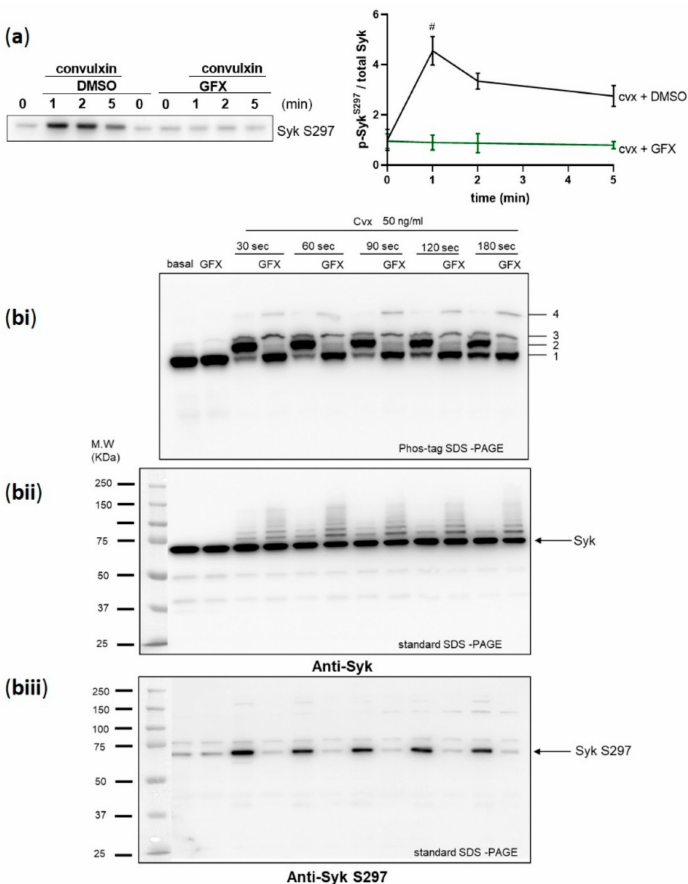
Figure 4. Syk S297 phosphorylation is stoichiometric and completely blocked by PKC inhibition. Washed human platelets were pre-incubated with DMSO as vehicle control or with pan-PKC inhibitor GF109203X (GFX) (5 µ M) at 37 ◦ C for 5 min prior to stimulation with 50 ng / mL cvx. ( a ) Platelet aggregation was stopped by adding Laemmli bu ff er directly in the cuvettes after 1, 2, and 5 min of stimulation under stirring conditions, and Syk S297 phosphorylation was analyzed by standard SDS-PAGE / Western blot analysis compared to total Syk. Quantitative analyses are represented as means ± SD from three independent experiments with platelets from three healthy donors. # p < 0.0001, DMSO versus GFX-treated platelets at 1 min. ( bi–biii ) Washed human platelets were stimulated under non-stirring conditions at 37 ◦ C, and platelets were lysed after the indicated time points by using Laemmli bu ff er for phos-tag SDS-PAGE. ( bi ) Samples were analyzed by phos-tag SDS-PAGE followed by immunoblotting using total Syk antibody. Same samples were analyzed by standard SDS-PAGE followed by immunoblotting using ( bii ) total Syk antibody or ( biii ) anti-Syk S297. Blots are representative of two independent experiments from two healthy